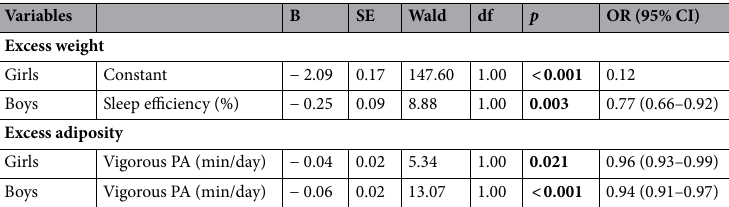
Table 3. Variables influencing excess weight and excess adiposity—logistic regression by the stepwise progressive method. df degrees of freedom, PA physical activity, OR (95% CI) odds ratio with a 95% confidence interval, SE standard error; significant associations are highlighted in bold. Results were derived from logistic regression by the stepwise progressive method of analysis with factors potentially related to excess weight and excess adiposity. B-coefficient can be interpreted as a predictor of the impact on the dependent variable. The model included age, total PA, light PA, moderate PA, vigorous PA, MVPA, steps per day, sleep duration, sleep efficiency, WASO and number of sleep awakenings. The last step of the regression model with the variables that best explained the analyzed relationships was presented. Activity levels were determined based on triaxial 24 h-accelerometry vector magnitude, defining 101–2295 cpm as light PA, 2296–4011 cpm as moderate PA, ≥ 4012 cpm as vigorous PA and ≥ 2296 cpm as MVPA 29